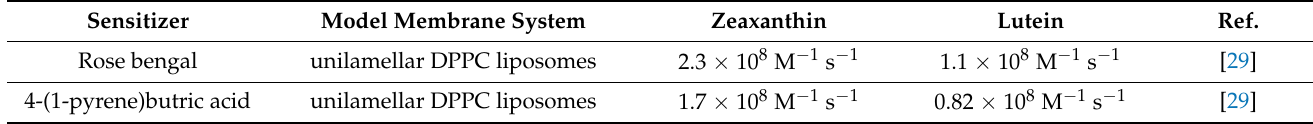
Table 2. Second-order singlet oxygen quenching rate constant of macular xanthophylls in lipid environment. Sensitizer Model Membrane System Zeaxanthin Lutein Ref. Rose